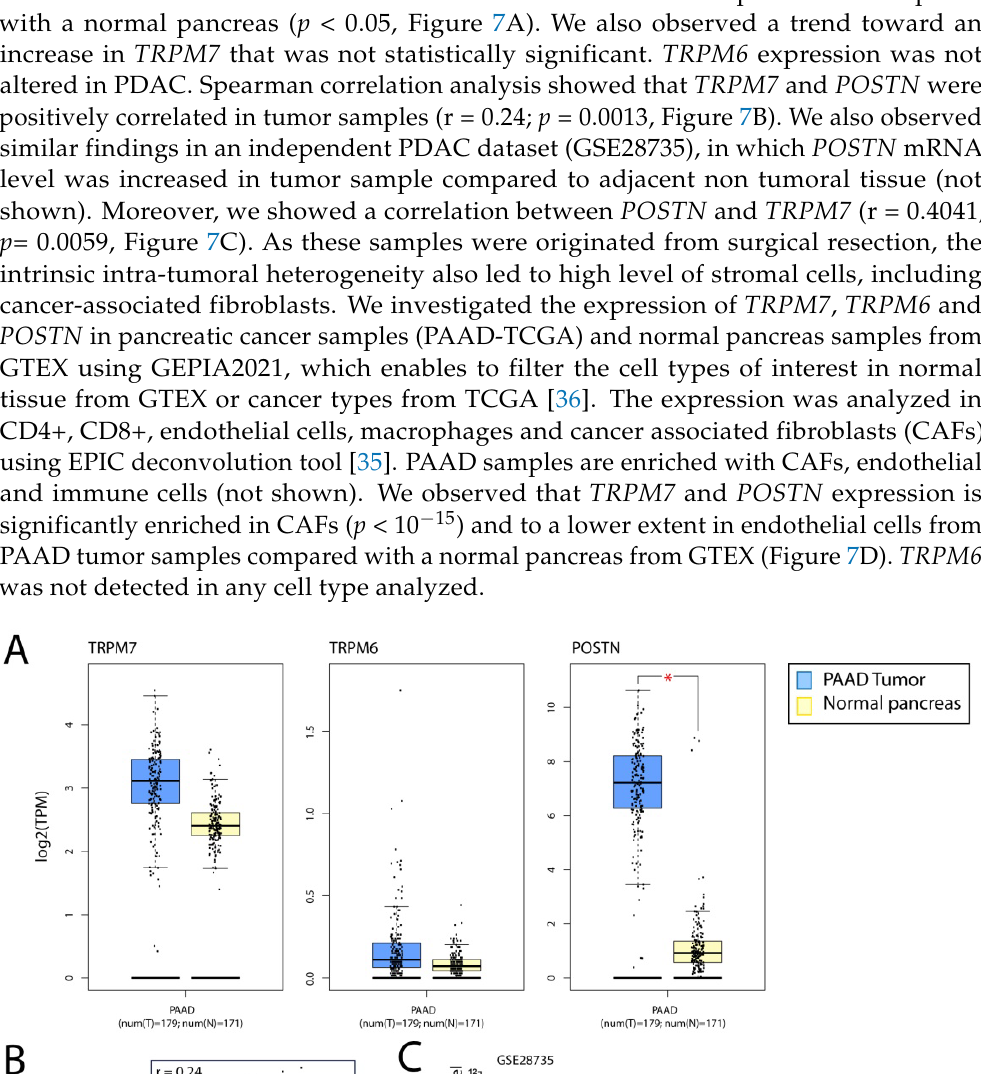
Figure 7. TRPM7 and POSTN expressions are increased in Cancer-Associated Fibroblasts (CAFs) in pancreatic cancer. ( A ) Relative mRNA levels of TRPM7, TRPM6 and POSTN in PDAC and a normal pancreas. Boxplots were generated with GEPIA from TCGA and GTEX datasets. Relative levels are expressed as log2 transcripts per million bases (TPM). * indicates p < 0.05 ( t − test). ( B ) Correlation analysis of TRPM7 and POSTN in PAAD TCGA dataset. ** indicates p < 0.01 ( t − test) ( C ) Correlation analysis of TRPM7 and POSTN in GSE28735 dataset. ** indicates p < 0.01 (paired t − test). ( D ) Relative